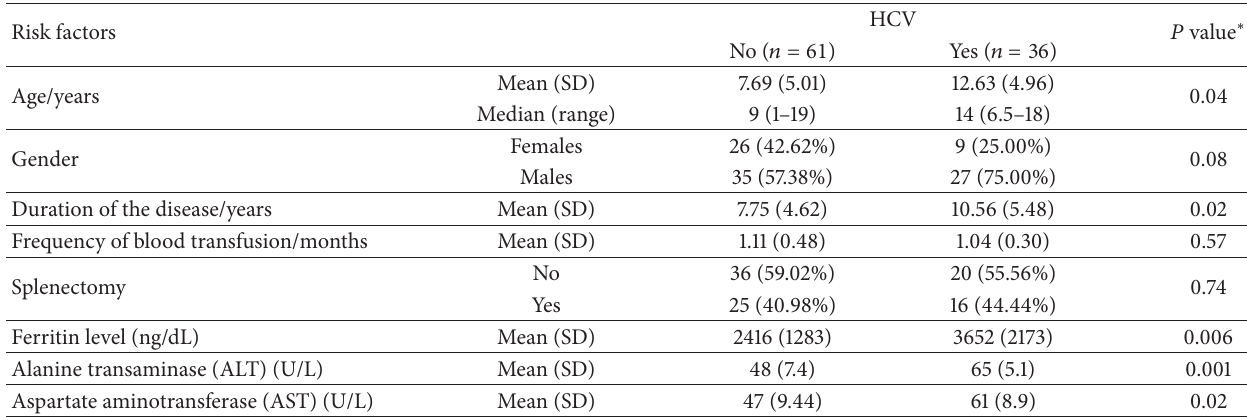
Table 3: Risk factors for HCV.